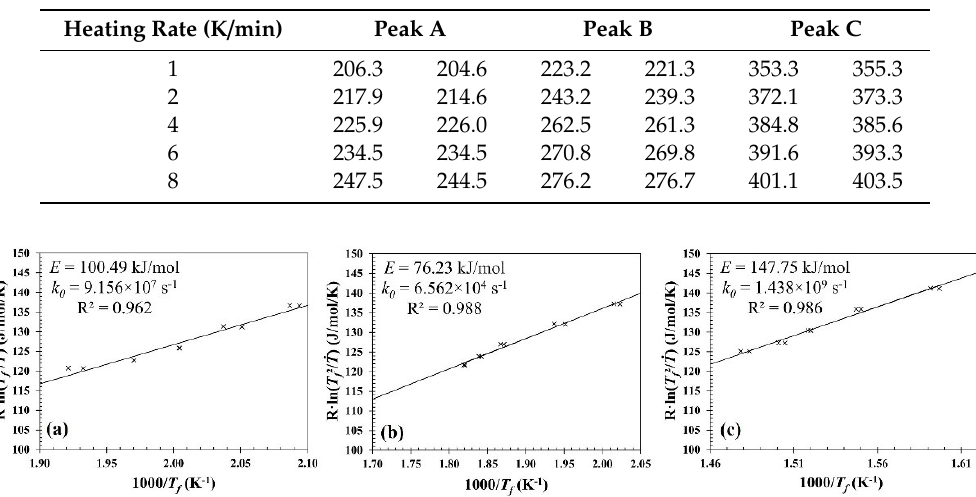
Table 2. DSC peak temperatures T f = T Peak obtained at di ff erent heating rates for the AlSi7Cu3.5Mg0.15 (Mn, Zr, V) alloy.